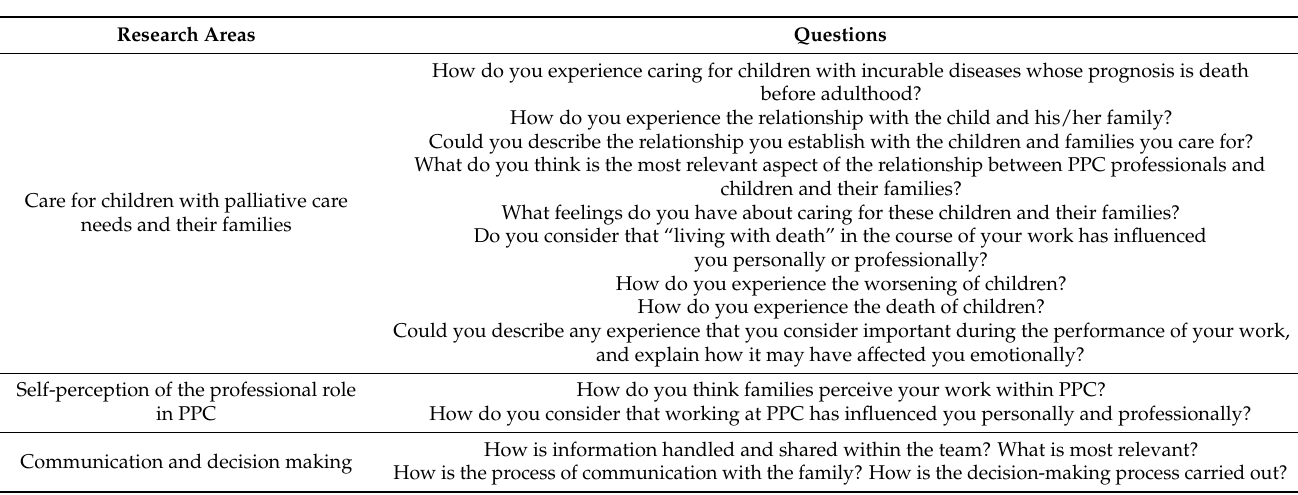
Table 2. Semi-structured question guide for professionals on the interdisciplinary pediatric palliative care